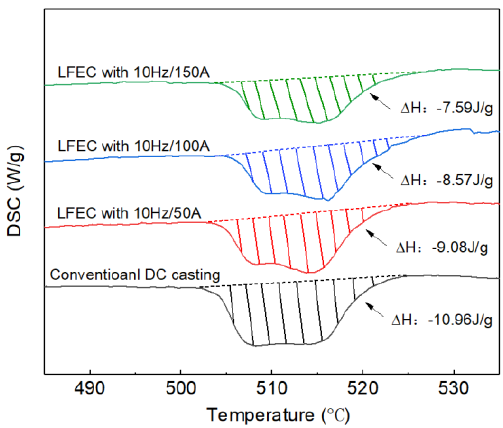
Figure 7. DSC curves of 2A97 as-cast alloy cast by the di ff erent electromagnetic